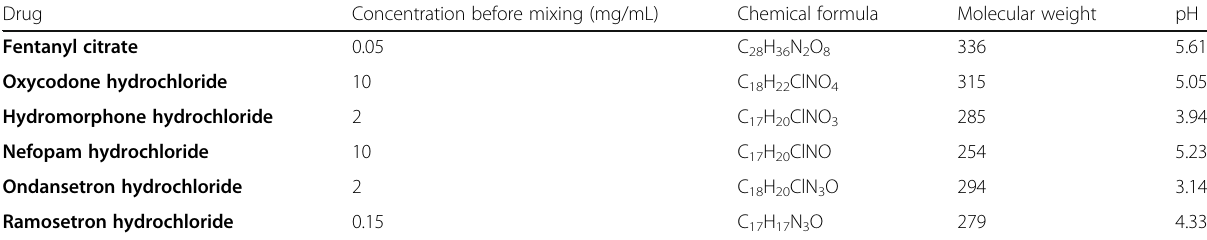
Table 1 Concentration, chemical formula, molecular weight, and pH of each drug used Drug